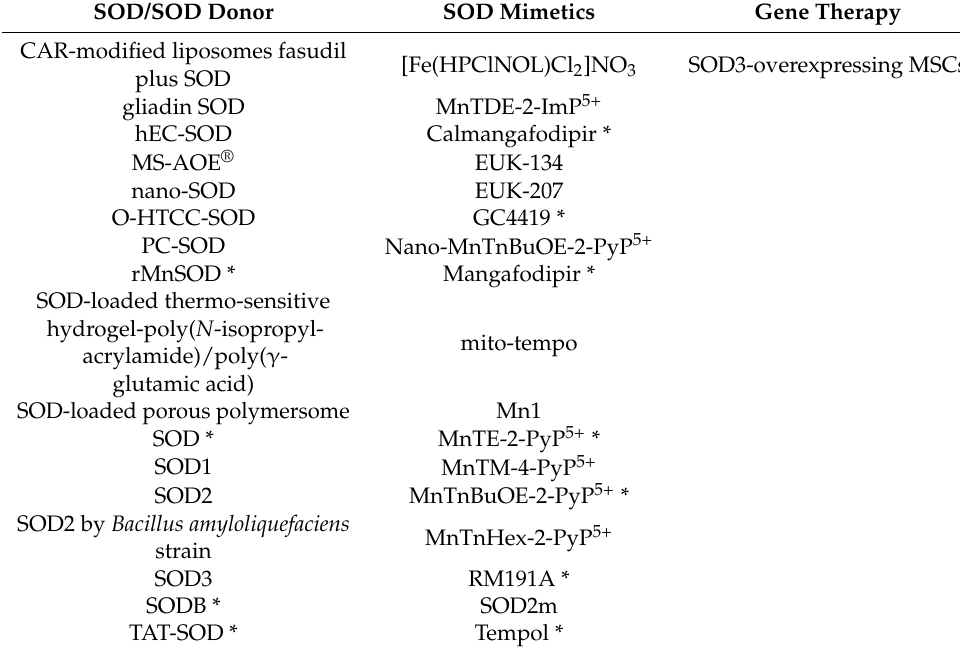
Table 3. SOD-based compounds tested for potential therapeutic applications between 2012 and